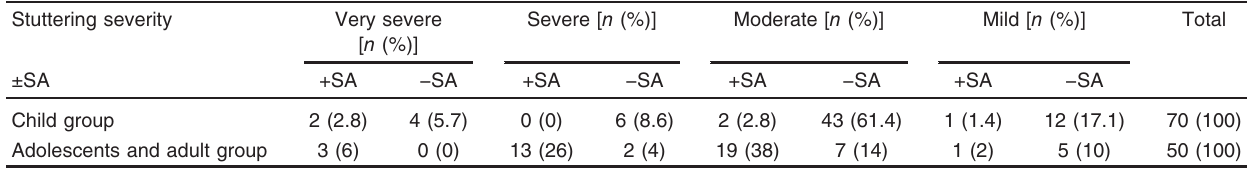
Table 2 Stutterers ’ clinical data as assessed by Stuttering Severity Instrument for Children and Adults-3 and Mini International Neuropsychiatric Interview for adult and Mini International Neuropsychiatric Interview for adolescents and children